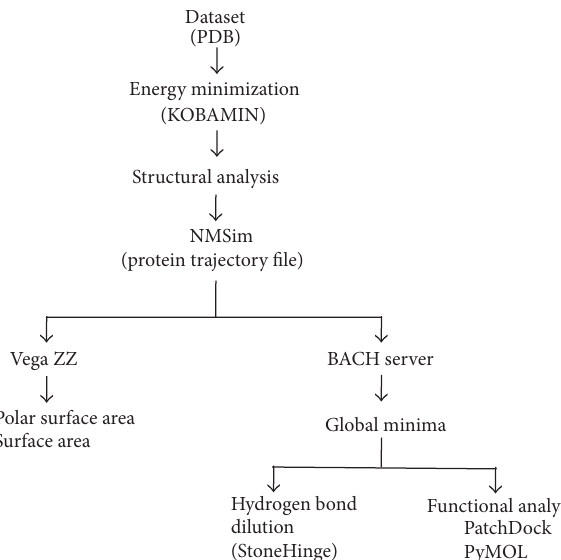
Figure 1: Flowchart illustrated the methodology and the various bioinformatics tools used in this